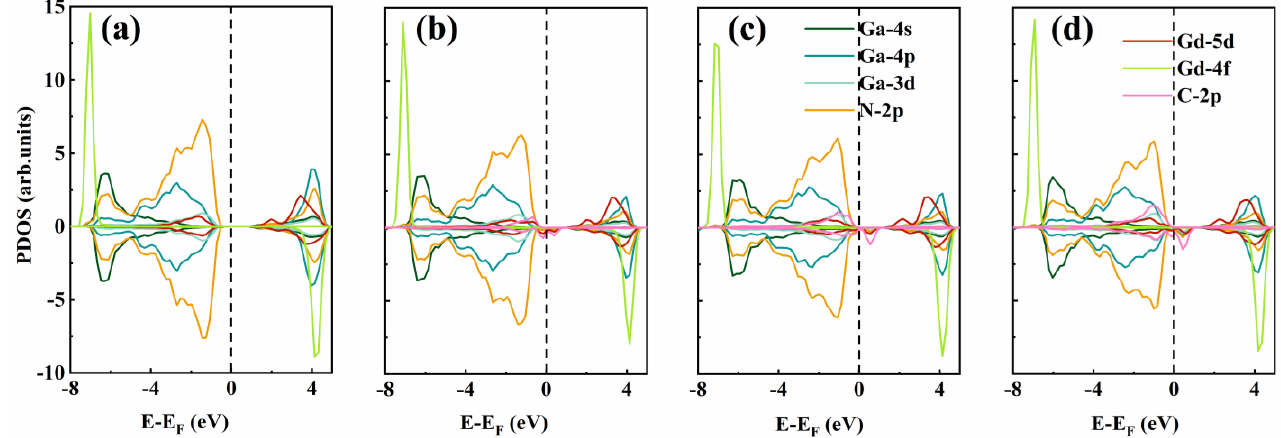
Figure 4. Spin-polarized partial density of states (PDOS) of ( a ) Ga 14 N 16 Gd 2 , (b) Ga 14 N 15 Gd 2 C 1 , (c) Ga 14 N 14 Gd 2 C 2 and (d) Ga 14 N 13 Gd 2 C 3 monolayers, respectively. The dashed lines represent the Fermi level which is taken to be 0.